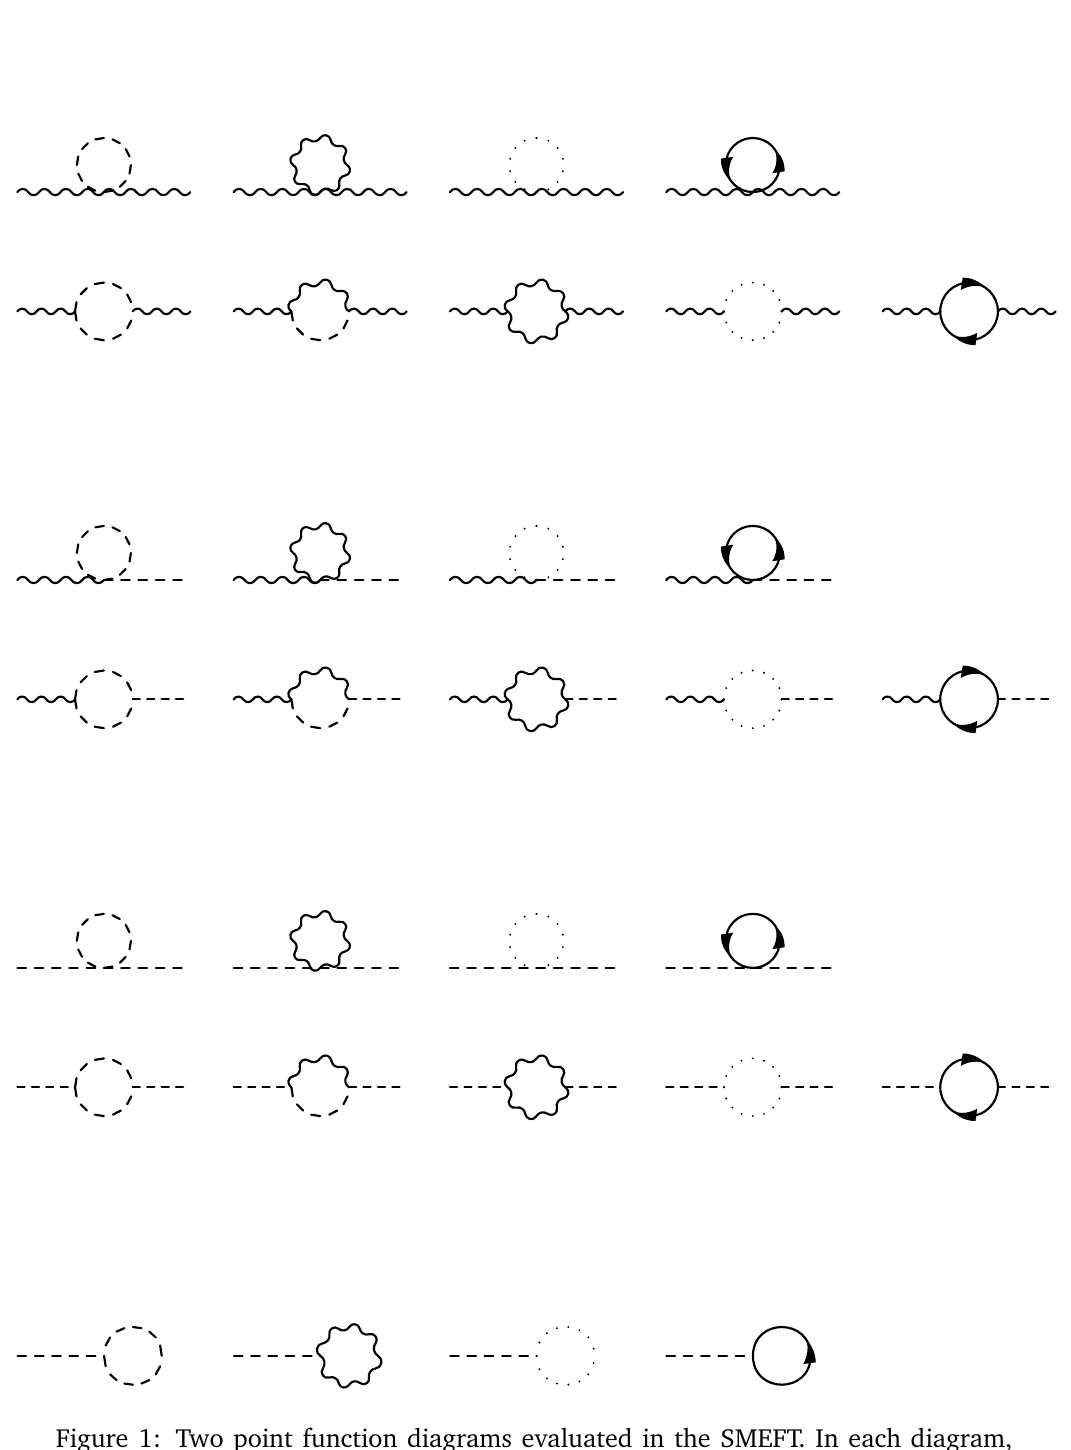
Figure 1: Two point function diagrams evaluated in the SMEFT. In each diagram, all possible operator insertions are implied in the one and two point functions. Here long dashed lines are scalar fields, including Goldstone boson fields, and short dashed lines are ghost